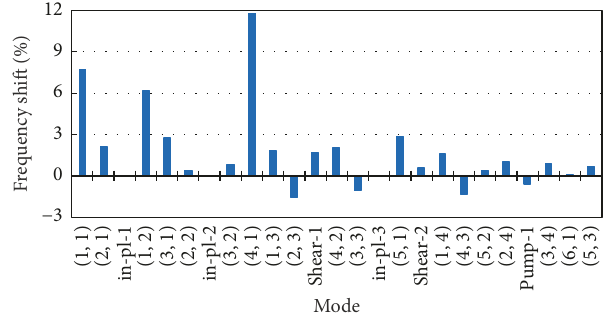
Figure11:Theshiftinnaturalfrequenciesofthedebondedsandwich